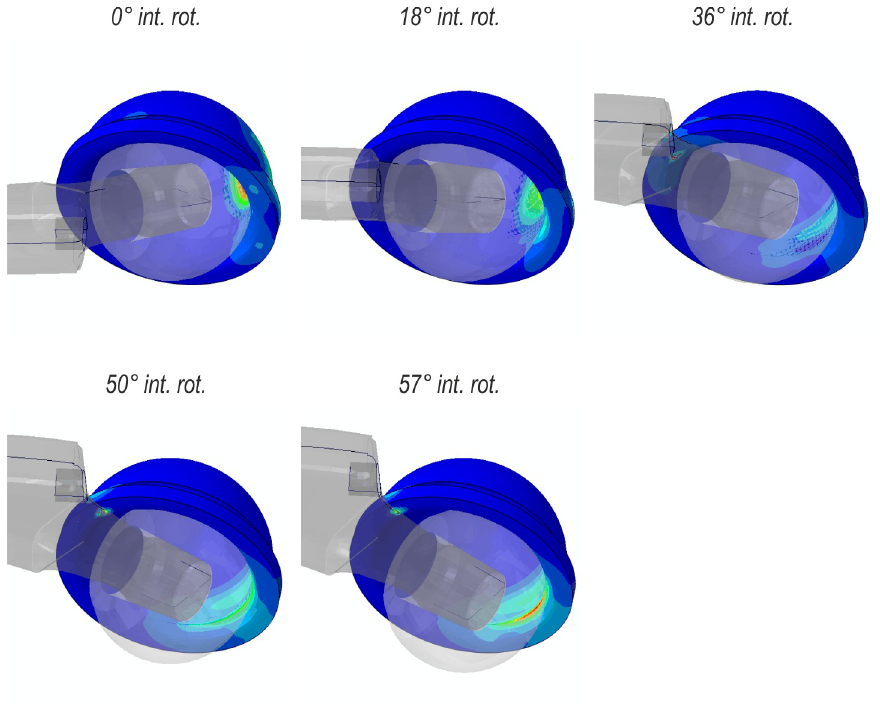
Fig 11. Lateral view of the liner during internal